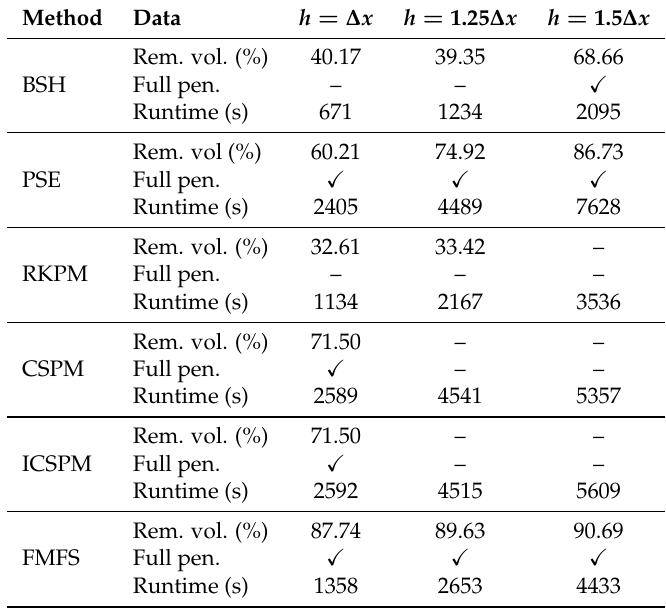
Table 5. Batch 3: Fine discretization using a total of 203k particles with the cubic B-spline